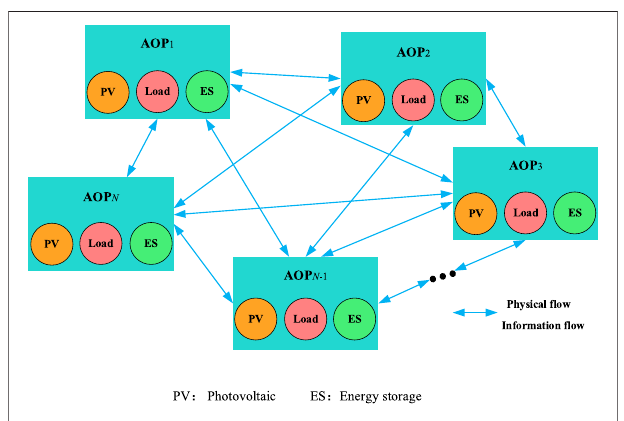
FIGURE 1 | The frame of AOP transactions and modeling the devices in the